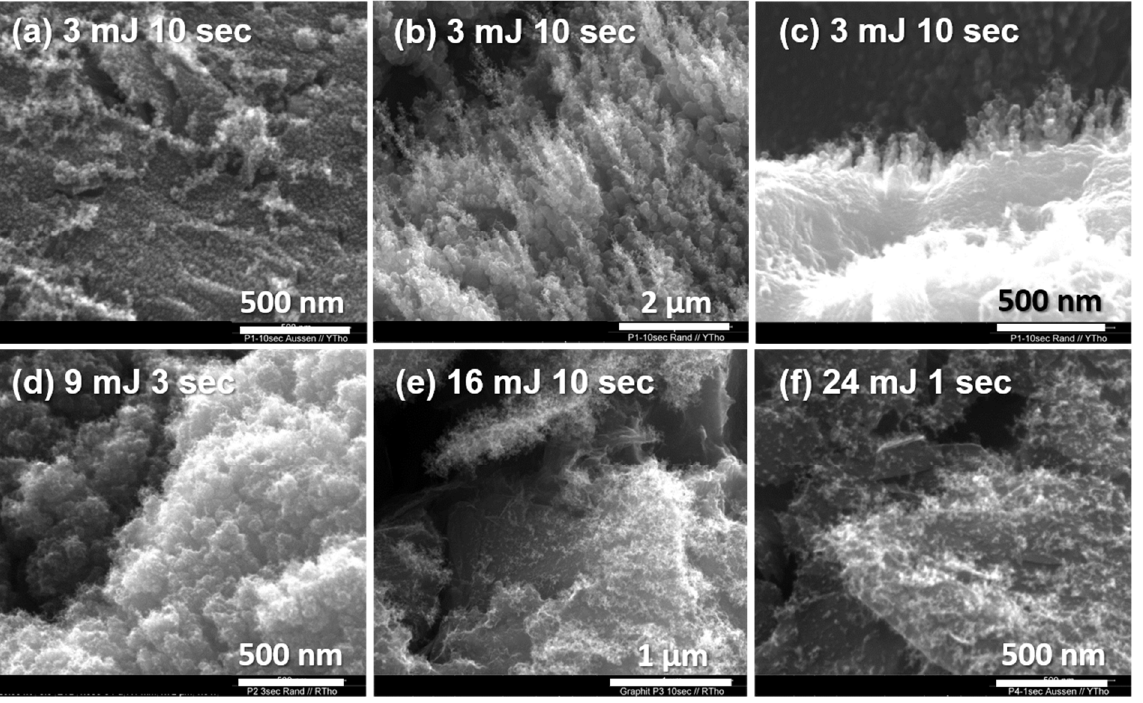
Figure 7. Zone 4. SEM images of deposited materials that were generated at different pulse energies and exposure times. and exposure